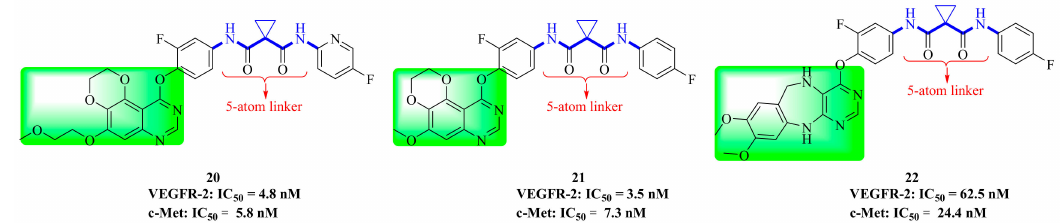
Figure 11. Quinazoline and diazepine derivatives of dual-target VEGFR / c-Met inhibitors.